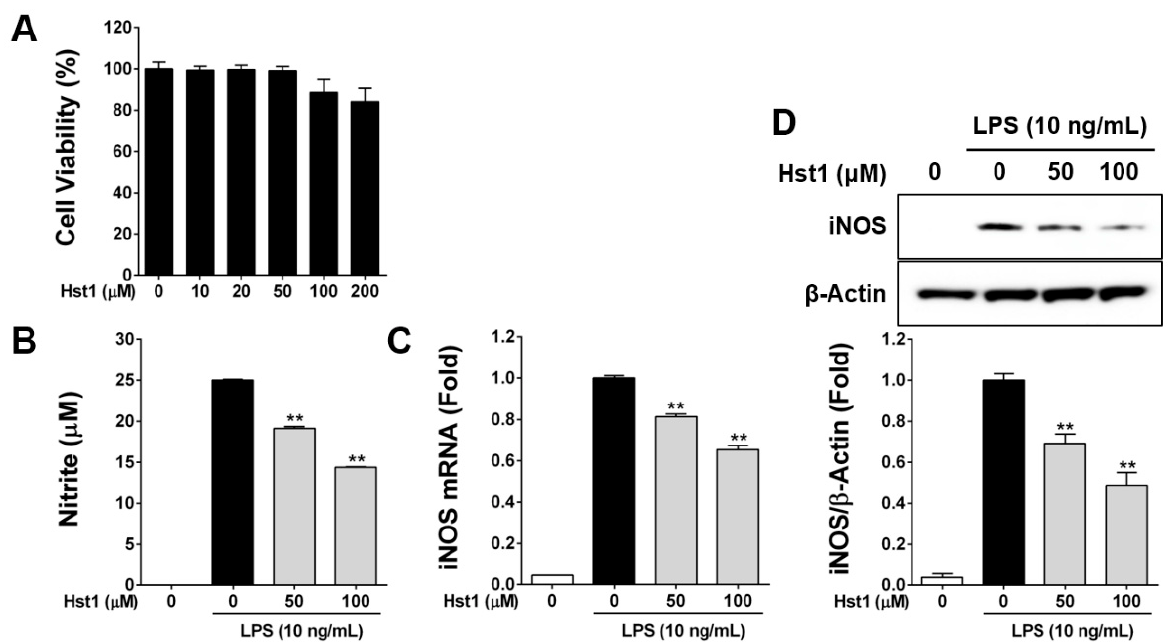
Figure 1. Effects of Hst1 on cell viability, nitric oxide production and iNOS expression in murine macrophage RAW264.7 cells. ( A ) Cell viability in HST1-treated cells was evaluated using the WST-1 assay. RAW264.7 cells were incubated with 10 to 200 µ M of Hst1 for 18 h. The results are displayed as a percentage of control samples. The lack of Hst1 induced cell toxicity up to 200 µ M is notable. Each value represents the mean ± SD and is representative of results obtained from three independent experiments. ( B ) Nitrite level was measured by the Griess assay. RAW264.7 cells were pre-treated with Hst1 at the indicated concentrations (50 and 100 µ M) for 2 h and then exposed to Hst1 with LPS (10 ng/mL) or LPS alone for 16 h. The culture supernatants were subsequently isolated and analyzed for nitrite levels. Results reveal a statistically significant and dose-dependent reduction in LPS-induced nitrite production in Hst1-treated cells. The values for nitrite are the mean ± SD from three independent experiments. ** p < 0.01 compared to treatment with LPS alone. ( C ) For the qRT-PCR of iNOS gene expression, RAW264.7 cells were treated by the same procedure for Griess assay. The levels of iNOS mRNAs were determined by qRT-PCR analysis and GAPDH mRNA served as the internal control for the normalization of iNOS mRNA expression. The dose-dependent and statistically significant reduction in iNOS gene expression in cells treated with Hst1 is notable. ( D ) For the Western blotting of iNOS protein, lysates were prepared from RAW264.7 cells and treated by the same procedure for Griess assay. Total cellular proteins (40 µ g) were resolved by SDS-PAGE, transferred to nitrocellulose membranes and detected with specific antibodies against murine iNOS and β -Actin served as the internal control for the normalization of iNOS protein expression. These results are displayed in fold of LPS alone samples. Results indicate that Hst1 treatment reduces protein levels of iNOS induced by LPS in a dose-dependent and statistically significant manner. Each value represents the mean ± SD and is representative of results obtained from three independent experiments. ** p < 0.01 compared to treatment with LPS